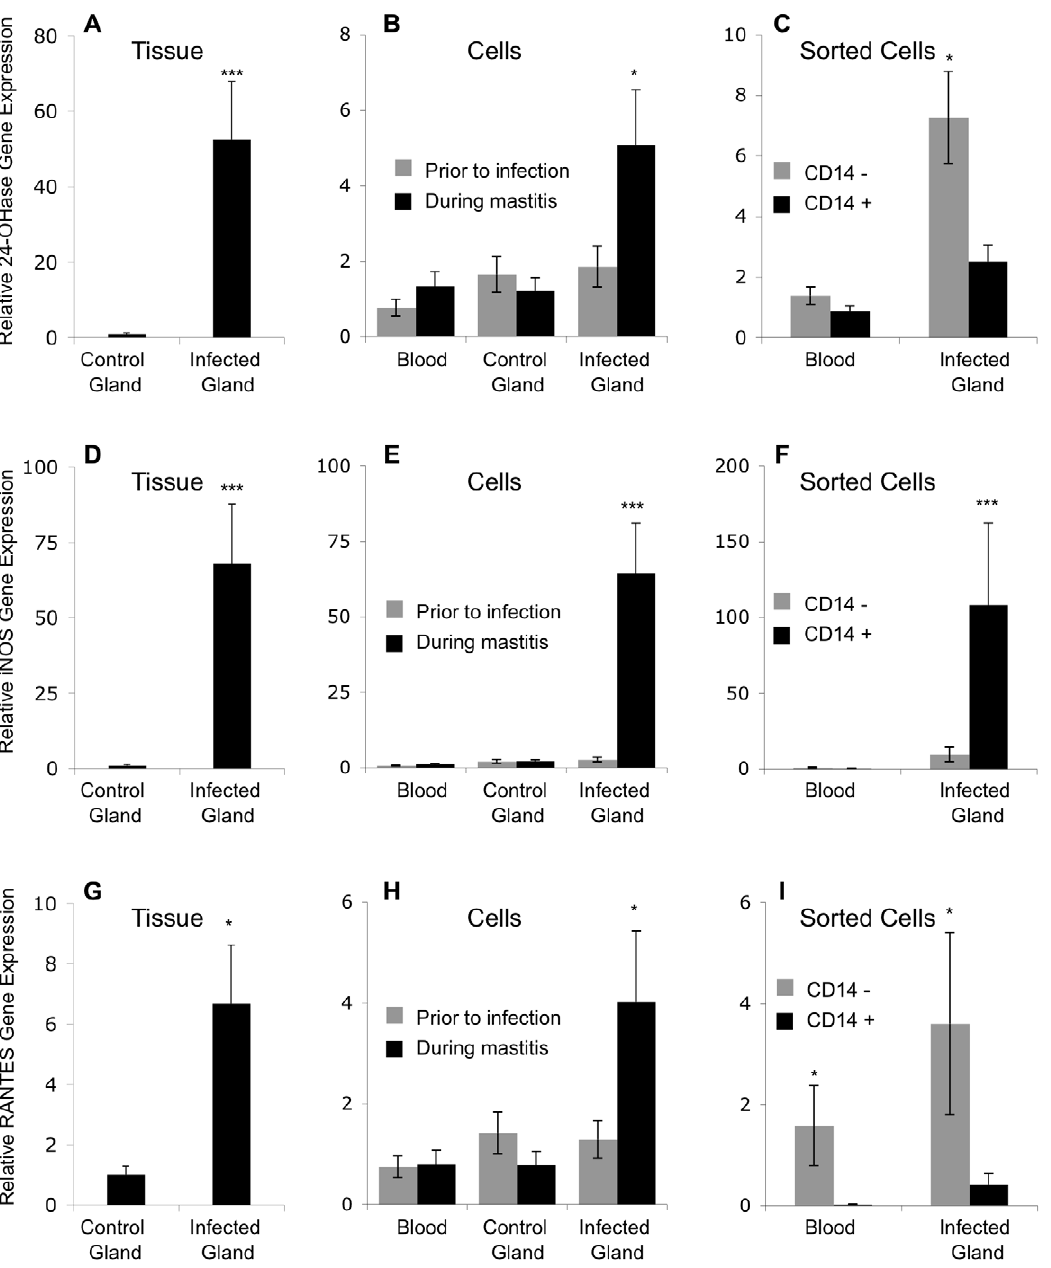
Figure 4. Expresssion of 1,25(OH) 2 D 3 inducible genes during mammary infection. Relative 24-OHase ( A–C ), iNOS ( D–F ), and RANTES ( G–I ) gene expression in mammary tissue, cells from peripheral blood and cell from milk during mammary infection. Tissue (n=3 cows) and cells (n=5 cows) were collected and sorted as in Figure 2. The amount of mRNA for each gene in each sample was determined by quantitative real-time RT-PCR and normalized to RPS9 mRNA. The relative amount of mRNA for each gene was determined using the 2 - DD Ct method. Data represent the mean 6 SE expression of each gene relative to expression in control tissue ( A ), or peripheral blood leukocytes ( B and C ). ANOVA was performed by SAS using the general linear model and multiple comparison tests were made using the Tukey adjustment; mean is different from other means* P , 0.05, *** P , 0.001.